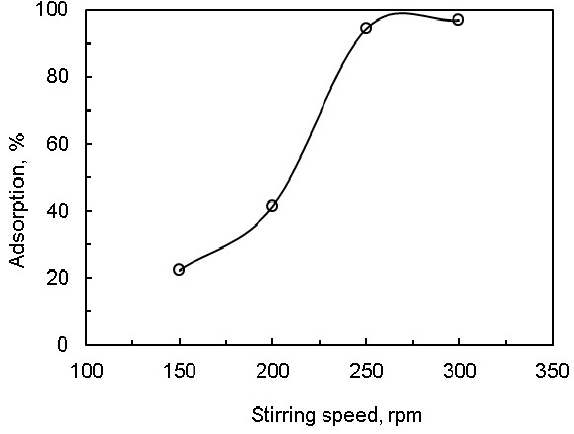
Fig.5. Effect of stirring speed on dye adsorption